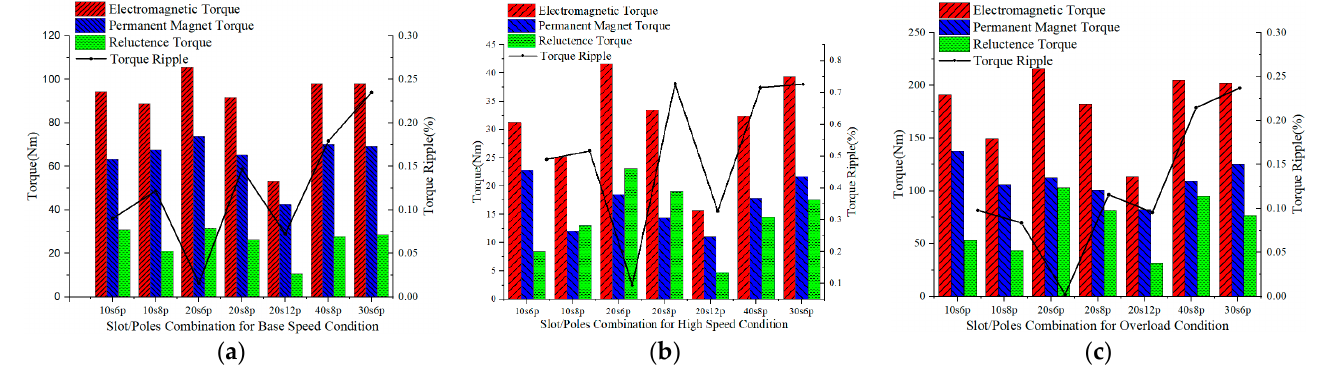
Figure 4. Torque characteristics in different slot/pole combinations: ( a ) base speed condition, ( b ) high-speed condition, and ( c ) overload speed condition.